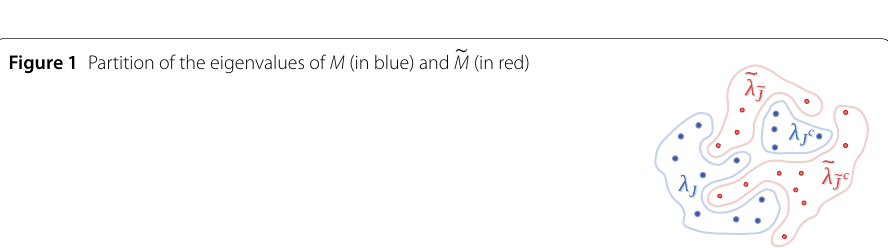
Figure 1 Partition of the eigenvalues of M (in blue) and (cid:2) M (in